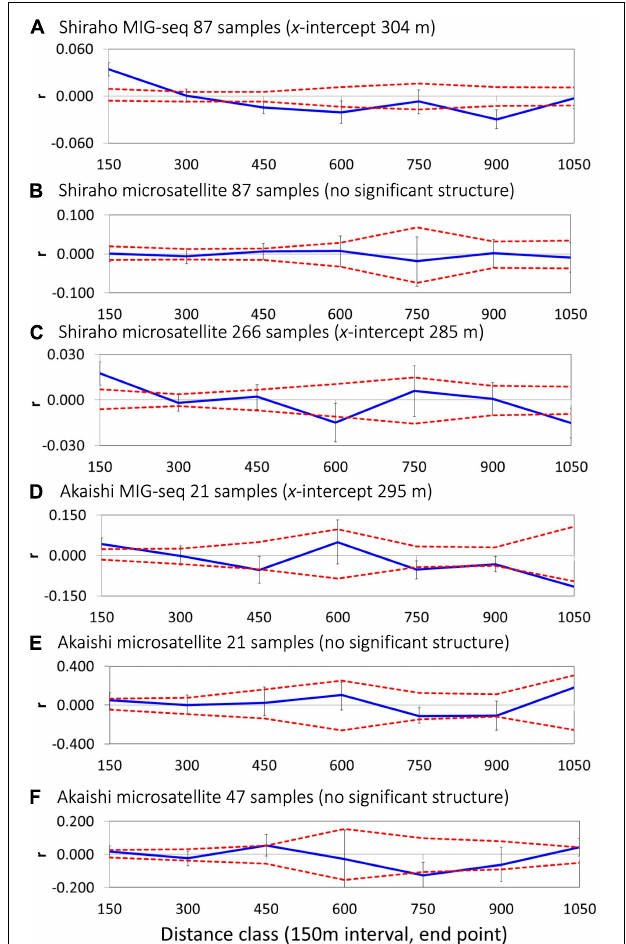
FIGURE 2 | Correlograms showing the spatial correlation r as a function of distance, 95% CI about the null hypothesis of a random distribution of Heliopora coerulea , and 95% confidence error bars about r as determined by bootstrapping. Autocorrelation for the distance class size of 150 m for Shiraho reef using (A) MIG-seq data ( n = 87), (B) nine microsatellite data ( n = 87), (C) nine microsatellite data ( n = 266) and that for Akaishi reef using (D) MIG-seq data ( n = 21) and (E) nine microsatellite data ( n = 21), (F) nine microsatellite data ( n =